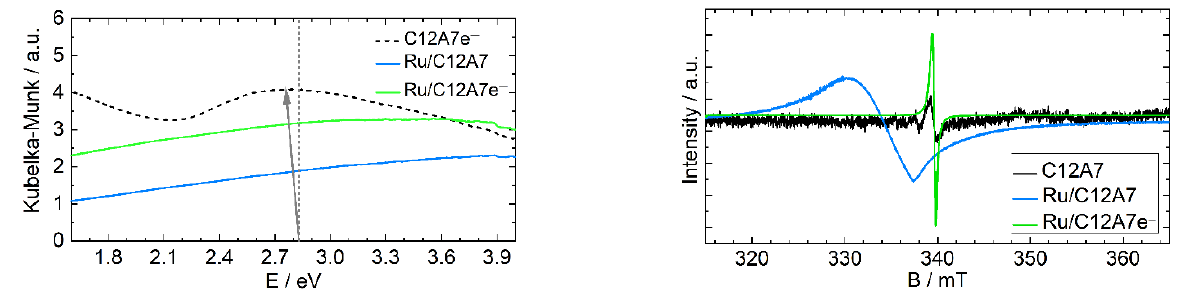
Figure 2. ( Left ): Kubelka–Munk-transformed DRUVVis spectra for Ru-impregnated samples: blue (g) Ru/C12A7, green (i) Ru/C12A7e − (3C) and dashed (d) C12A7e − (3C). The dotted line at 2.83 eV corresponds to the absorption peak maximum for N e = 1 · 10 18 cm −3 [21]. The arrow indicates the shift with increasing N e . ( Right ): first derivative EPR spectra for (a) C12A7 (black), (f) Ru/C12A7 (blue) and (i) Ru/C12A7e − (green) samples, intensities are not normalized.